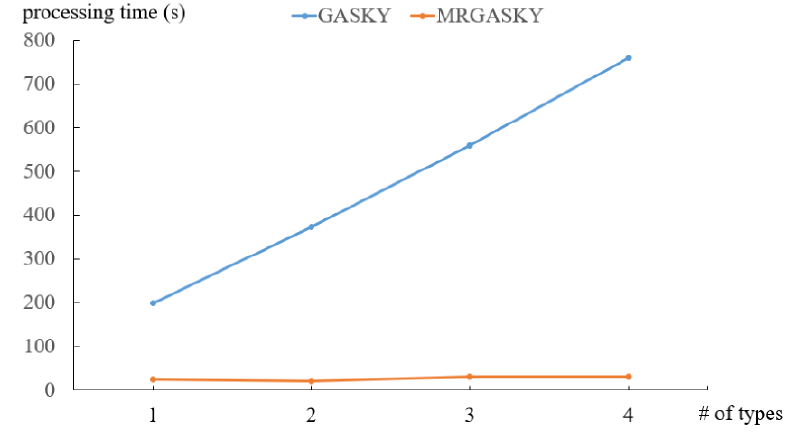
Figure 15. Processing Time of